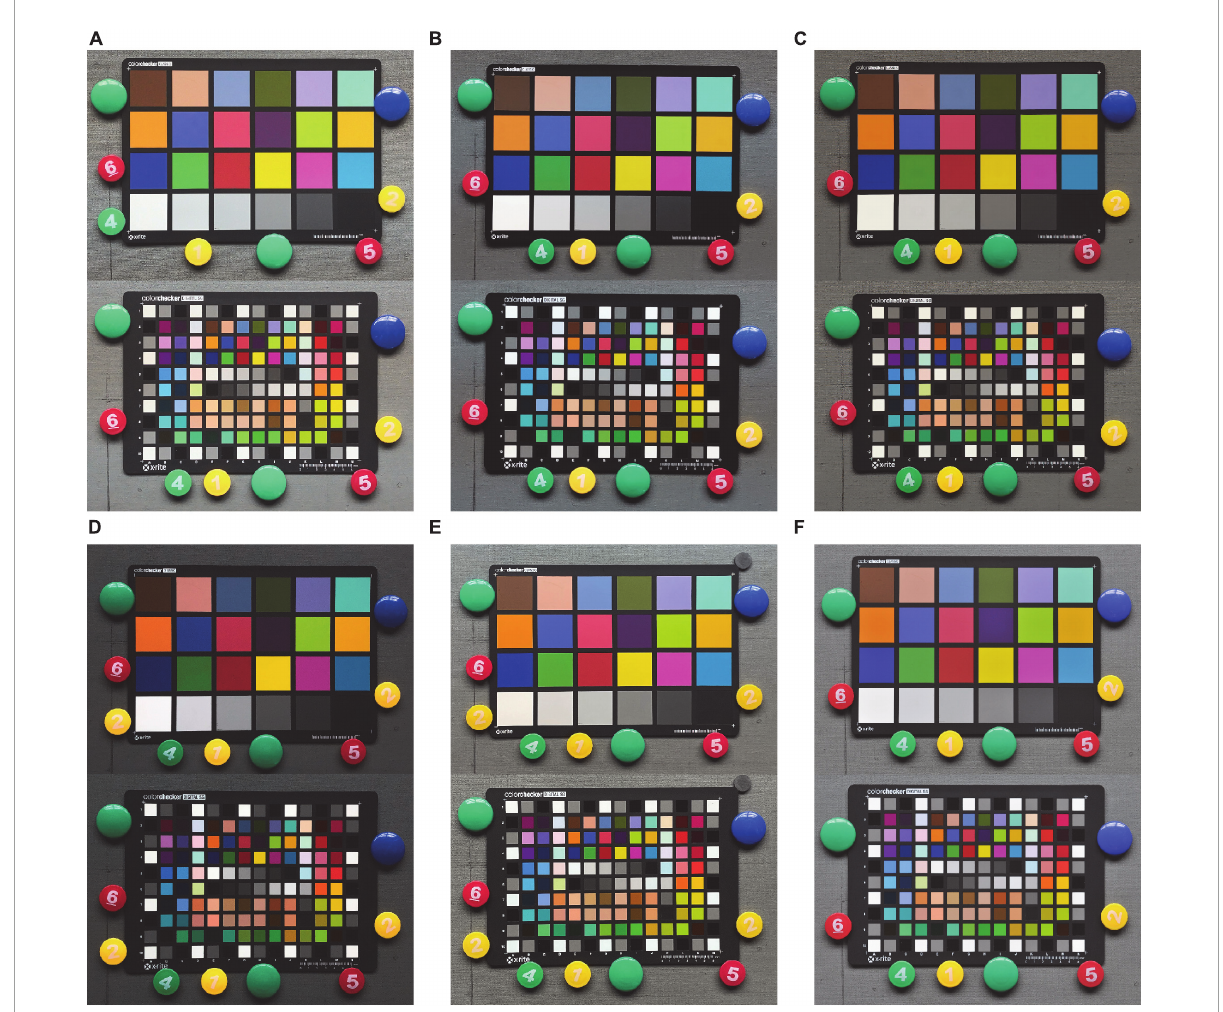
FIGURE3 JPG pictures of the Xrite CC chart and SG chart were taken by cell phones, photos of the CC chart are arranged on the top, SG color chart is arranged on the bottom: (A) Huawei Mate10, (B) Meizu 17Pro, (C) Xiaomi12S Ultra, (D) iPhone 8, (E) iPhone 12, and (F) Nikon D3x.